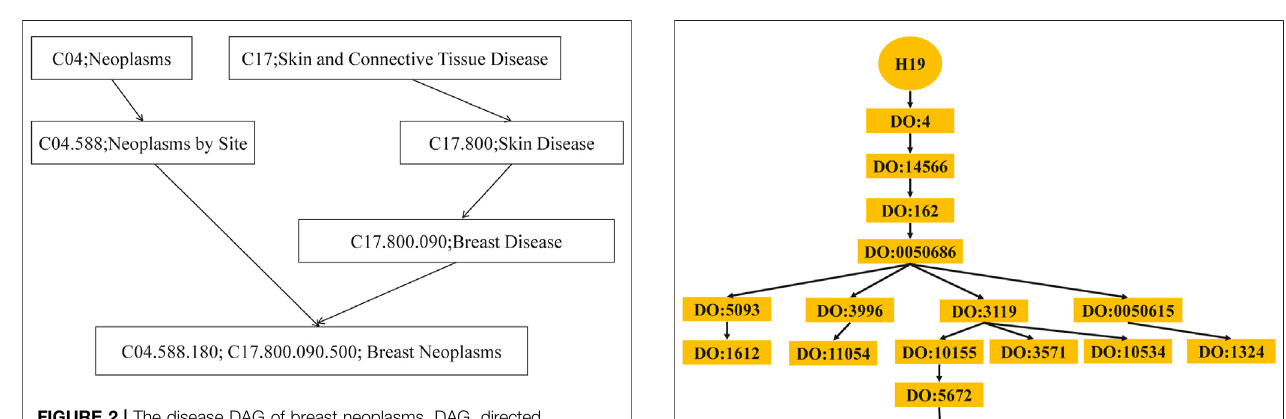
FIGURE 2 | The disease DAG of breast neoplasms. DAG, directed acyclic graph.